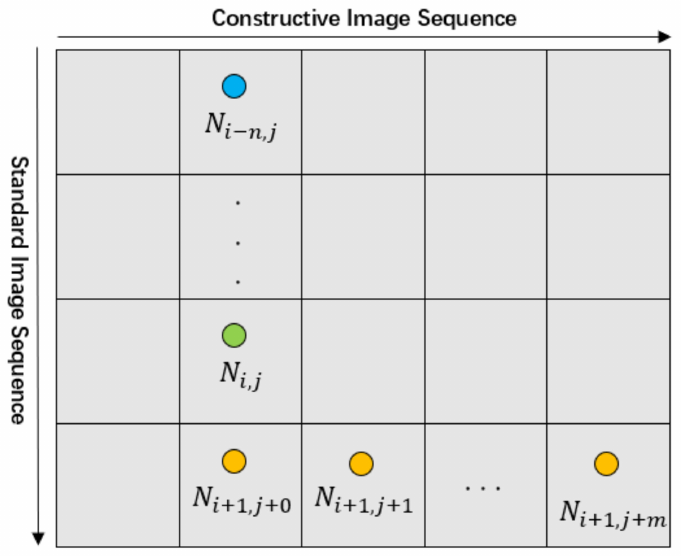
Figure 5. Diagram of forwarding and backward state recursion in dynamic